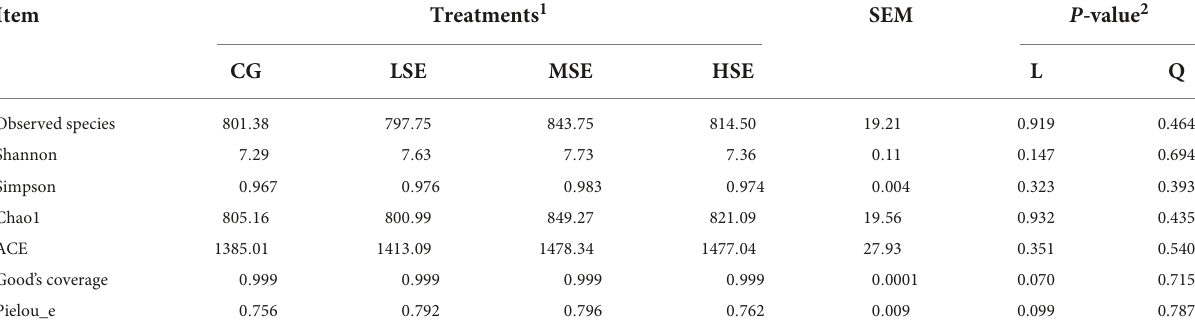
TABLE 3 Operational taxonomic unit count and α diversity estimation based on the 16S rRNA gene sequencing analysis of the four different treatment